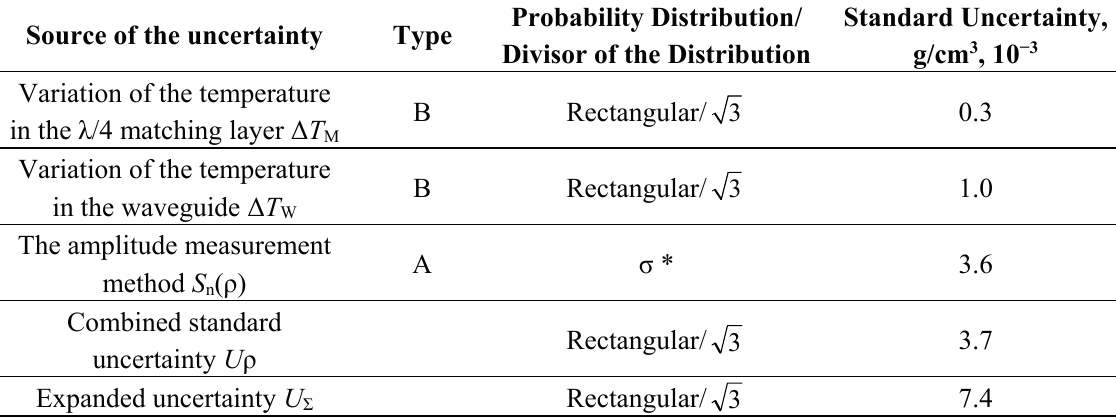
Table 4. Sources of the measurement uncertainty and their